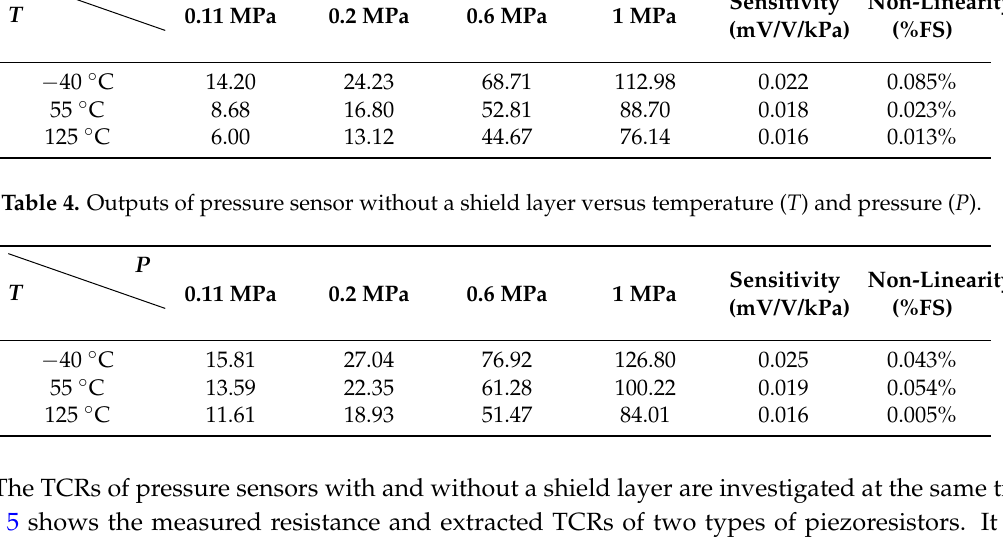
Table 3. Outputs of pressure sensor with a shield layer versus temperature ( T ) and pressure ( P ).